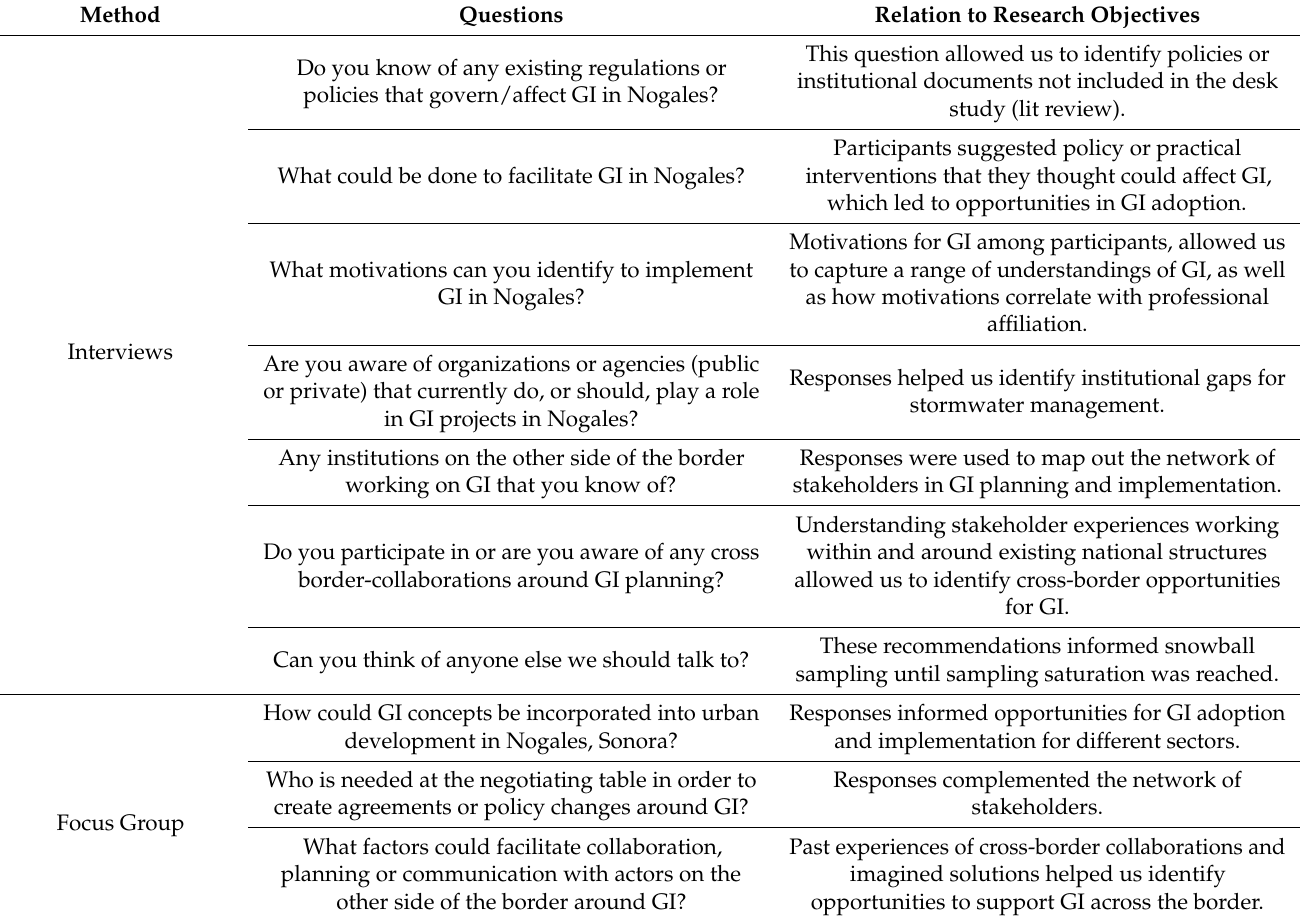
Table 3. Interview and focus group questions and relation to research objectives